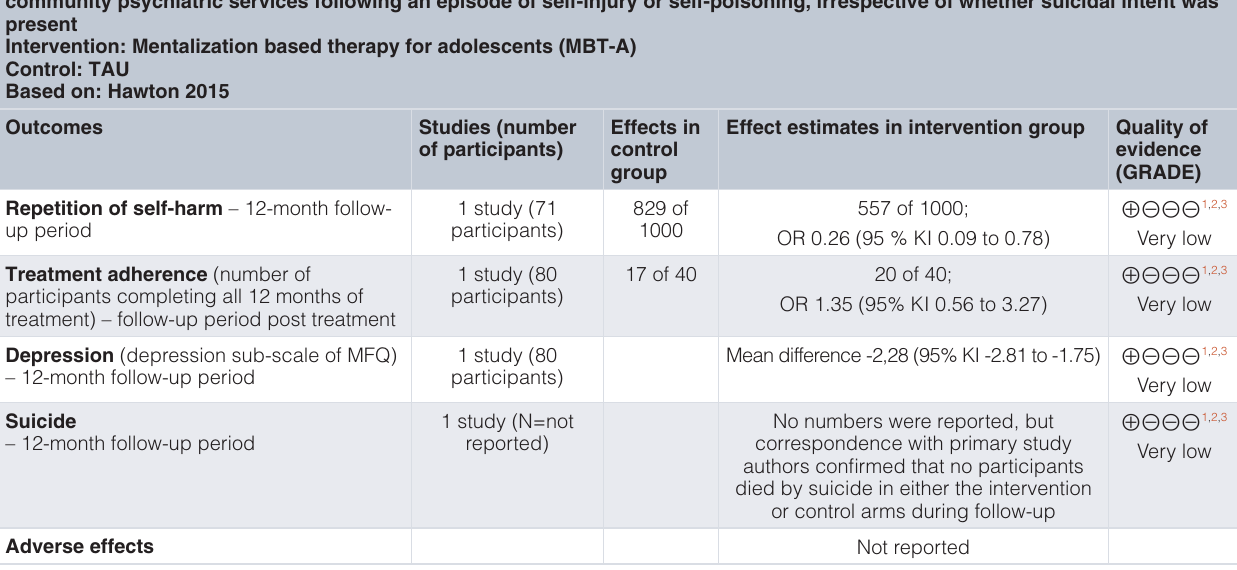
Table 8. GRADE-assessment: Interventions for existing self-harm: mentalization based therapy adapted for adolescents (MBT-A) versus treatment as usual (TAU). Population: Adolescents, 12 to 17-year olds, diagnosed with comorbid depression presenting to emergency departments or community psychiatric services following an episode of self-injury or self-poisoning, irrespective of whether suicidal intent was